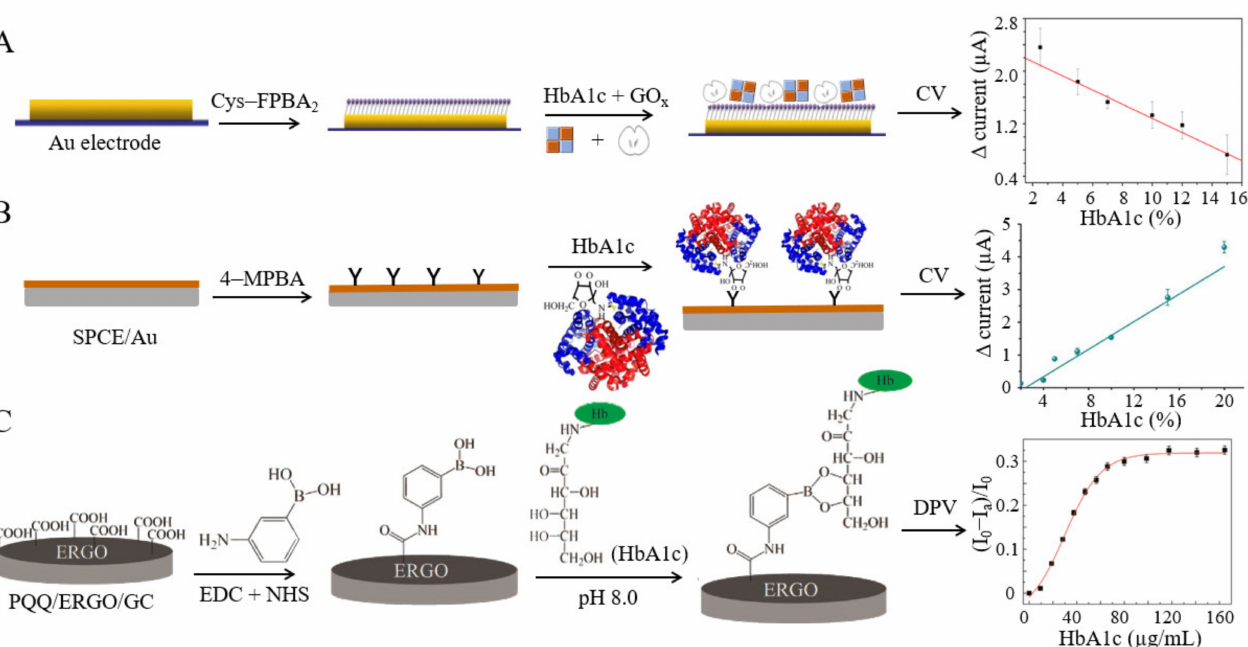
Figure 2. ( A ) Electrochemical sensor based on the HbA1c and GO x competition mechanism, as well as the ∆ CV responses of HbA1c (this figure was adapted from [35] with some modifications); ( B ) Electrochemical sensors based on 4-MPBA specific recognition and the ∆ CV responses of HbA1c (this figure was adapted from [42] with some modifications); ( C ) Recognition of HbA1c of PBA- PQQ/ERGO/GC electrode and linear calibration plot of I d value vs. the concentration of HbA1c (this figure was adapted from [40] with some